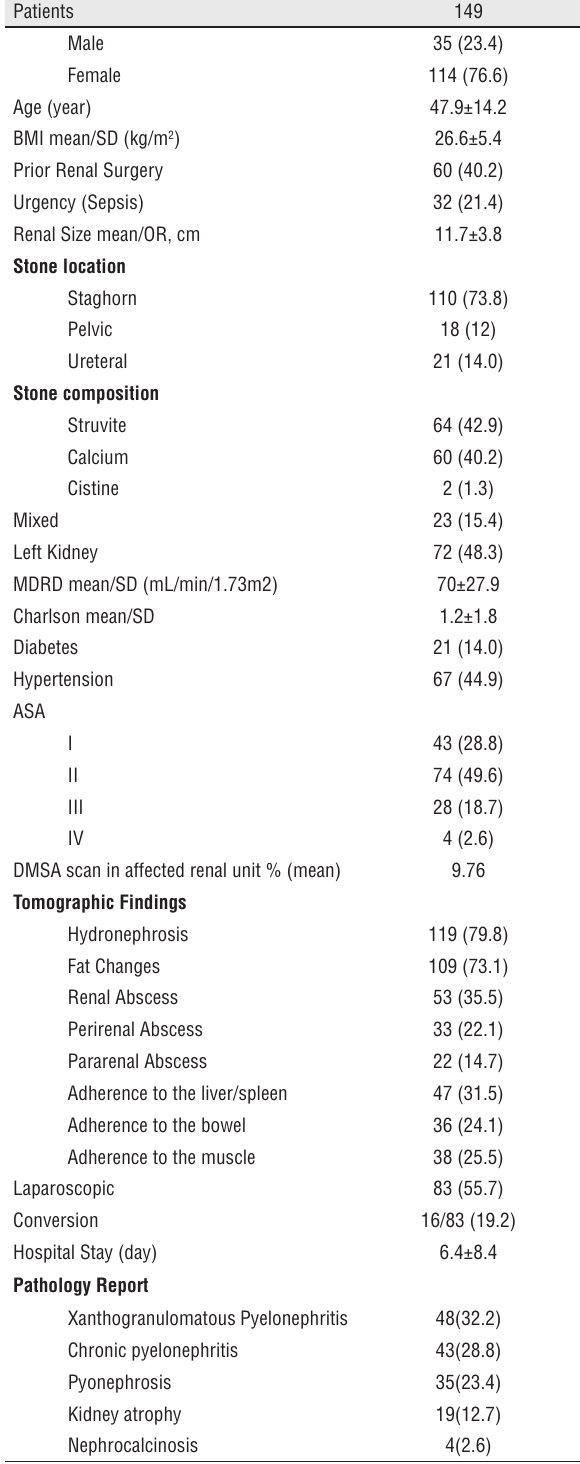
Table1 - Patient characteristics and Perioperative